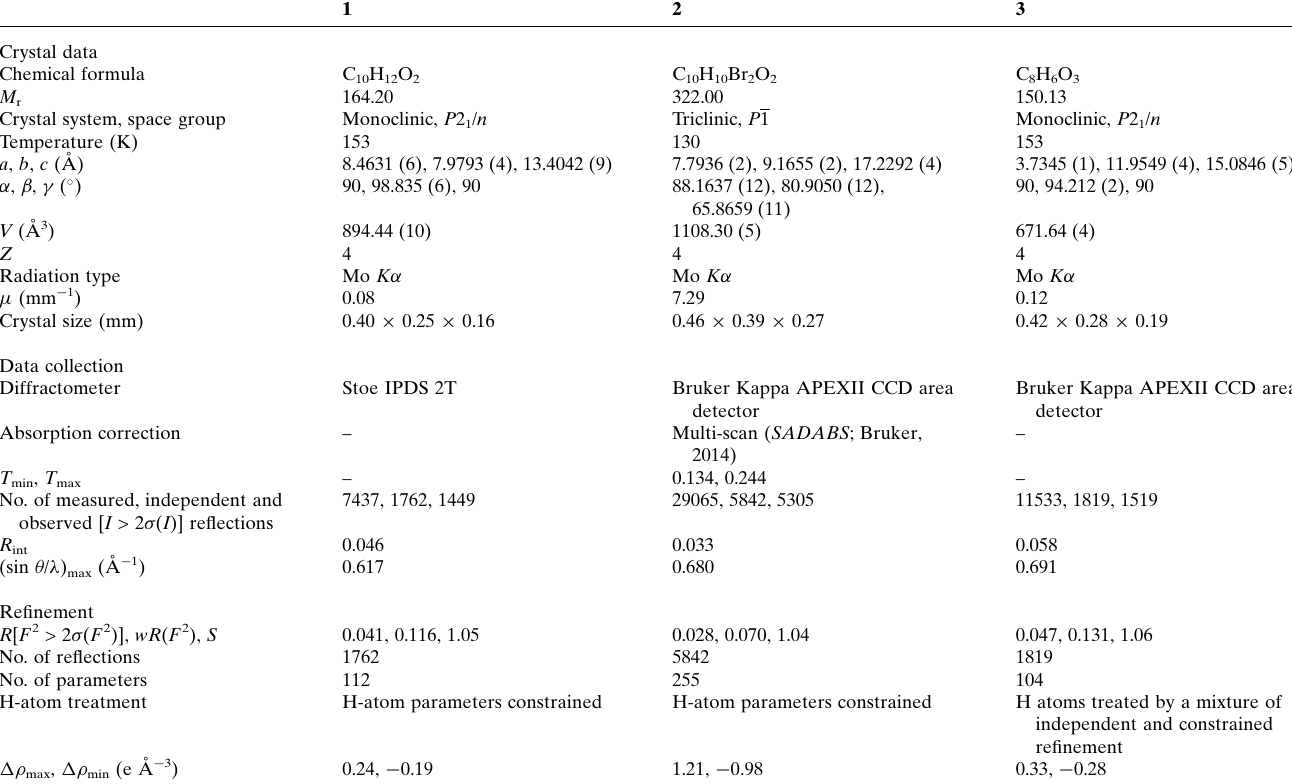
Table 4 Experimental